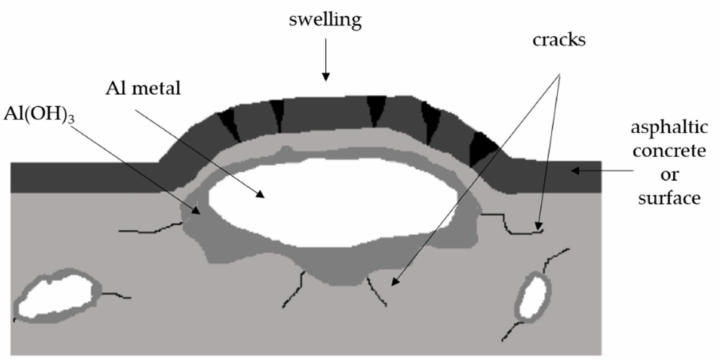
Figure 4. MSWIBA or mixtures with MSWIBA swelling, due to the aluminium content and high pH.